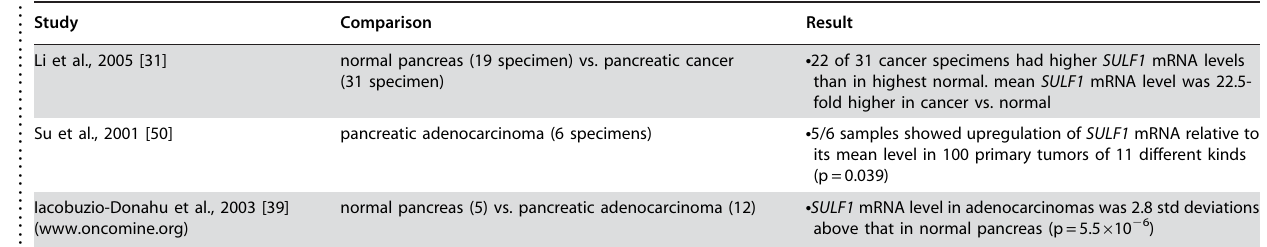
Table 1. SULF1 mRNA expression in human pancreatic cancers .. ... .... ... ... .... ... ... .... ... ... .... ... ... .... ... ... .... ... ... .... ... ... .... ... ... .... ... ... .... ... ... .... ... ... .... ... ... .... ... ... .... ... ...